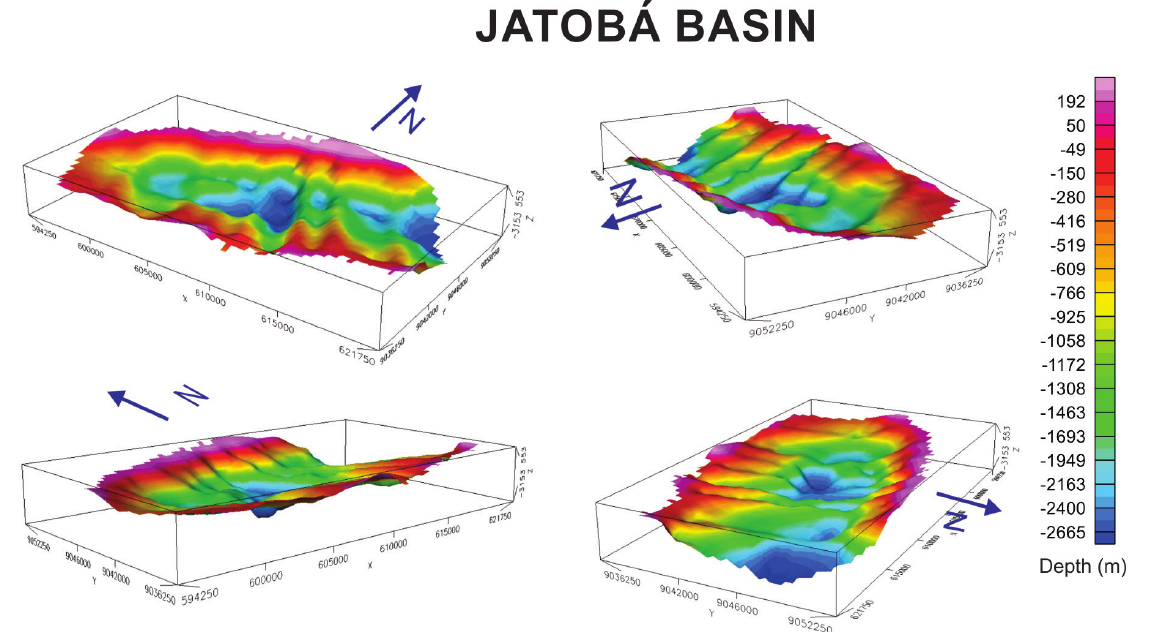
Figure 7. Three-dimensional framework of the Jatobá Basin study area. The model indicates that the basin is semi-graben-shaped, contains small horsts, a faulted northwest border and deepening in the study area of approximately 2900